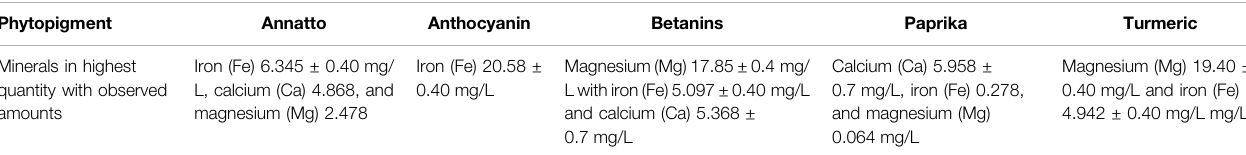
TABLE 4 | ICP-OES results for selected phytopigments with reference values in mg/mL. Phytopigment Annatto Minerals in highest quantity with